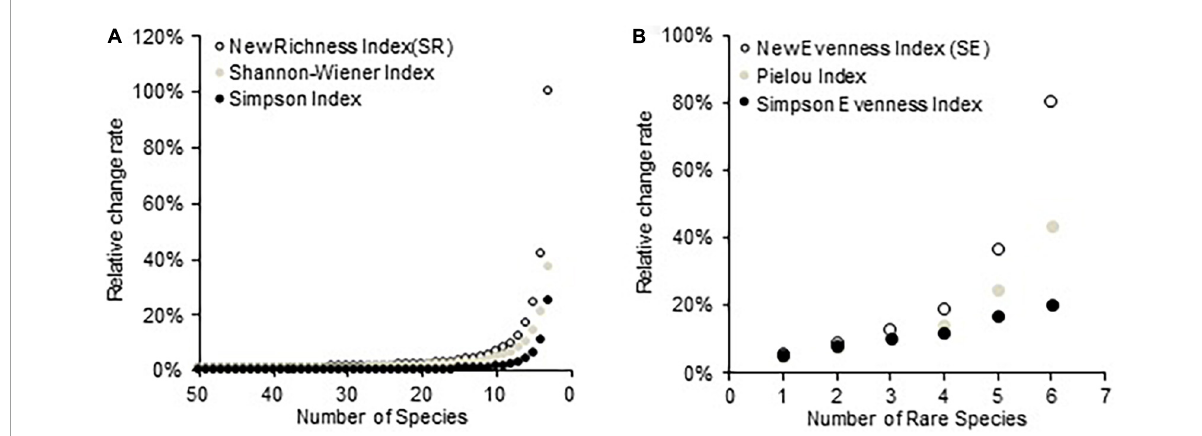
FIGURE2 (A) Relative change rates of three diversity indices to the variation of species number in a series of simulated communities and (B) relative change rates of three evenness indices to the variation of rare species number in a series of simulated